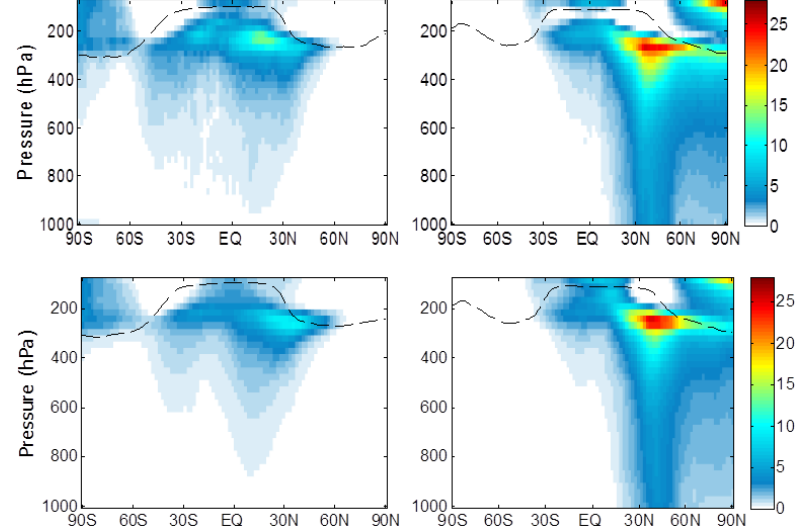
Figure 8. Aviation-induced OH perturbations (10 − 4 1 moleccm − 3 ) during January (left) and July (right). CAM5 is in the top panel, while CAM4 is in the bottom. The dashed line indicates the tropopause.